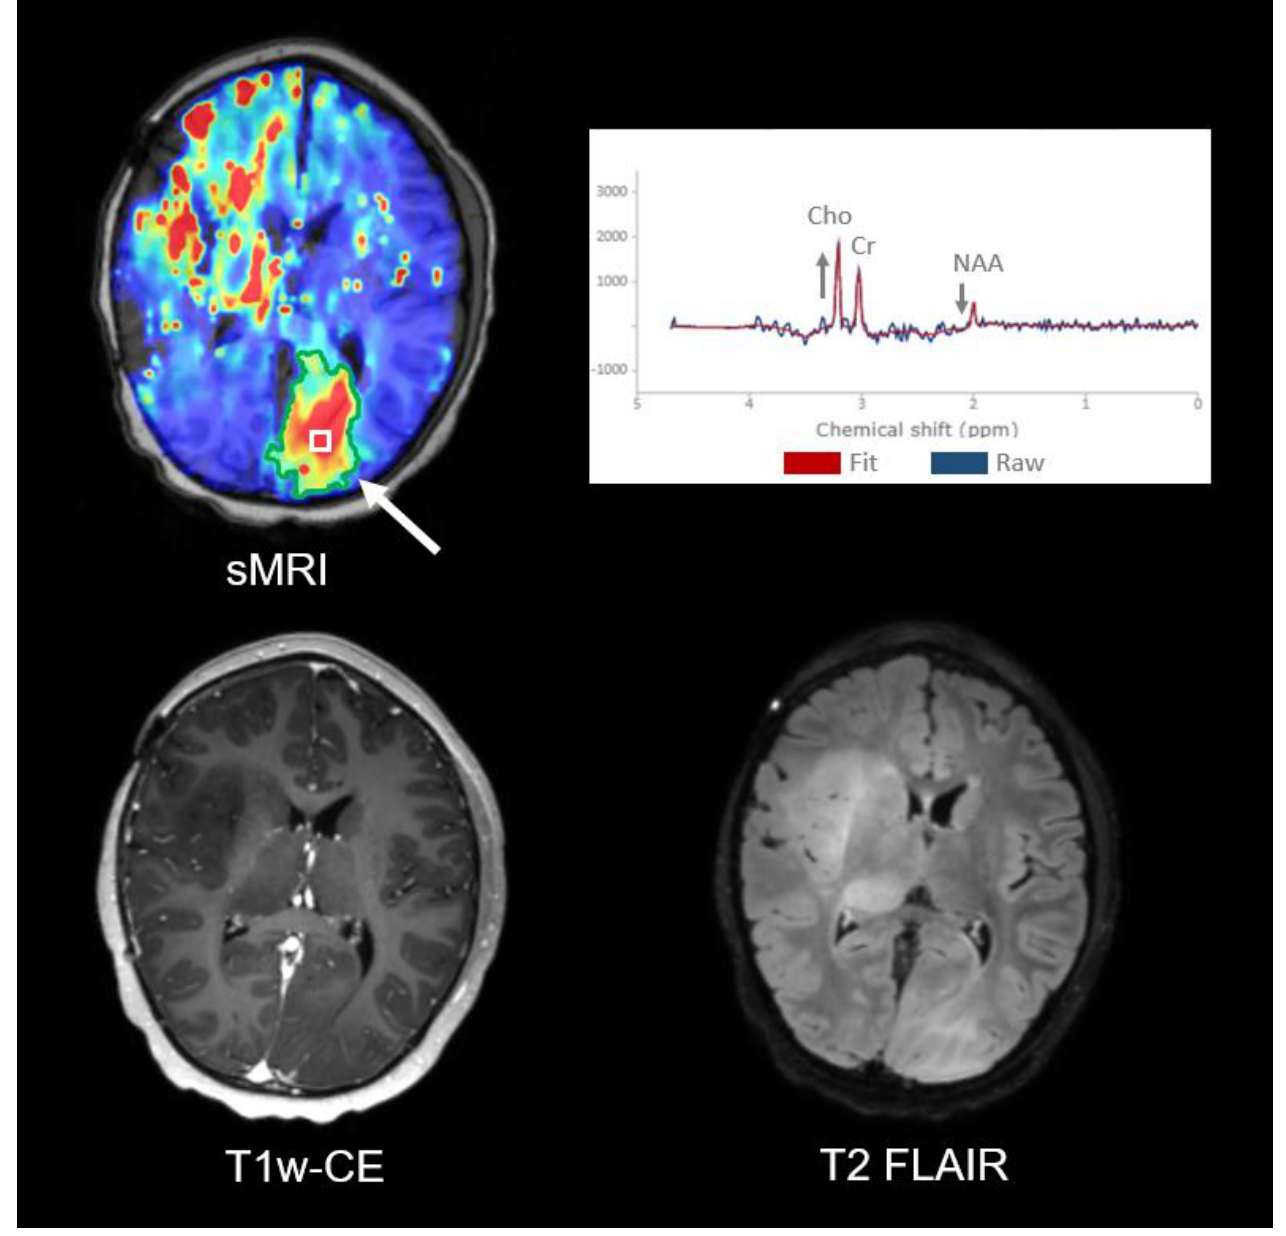
Figure 5. Out-of-field recurrence in Subject 1. Imaging of the sMRI, T1w-CE, and T2 FLAIR at the recurrence date (15 months post-RT) with the site of tumor progression indicated by the white arrow on sMRI. The green contour shows the additional 30.50 cc metabolically active mass at the Cho/NAA ≥ 2x threshold on the sMRI. The spectra identified by the boxed ROI on the sMRI map shows clearly elevated Cho and decreased NAA (gray arrows), corresponding to presence of tumor. The lesion is not identifiable with confidence on the T1w-CE and is better seen on sMRI than T2 FLAIR.